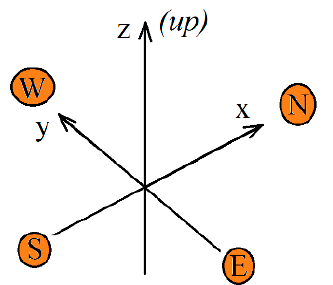
Figure 3. North (N), South (S), East (E), and West (W) in COMSOL Multiphysics (CM) for solar irradiance direction.